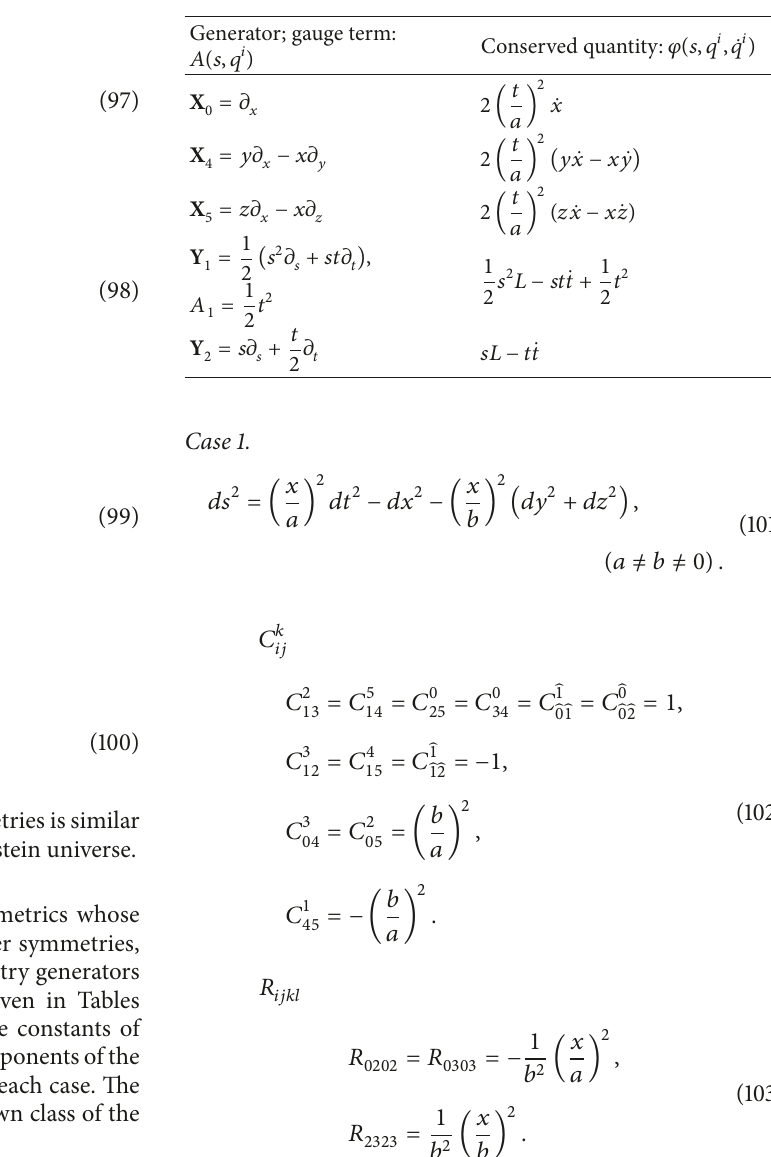
Table 17: Conserved quantities corresponding to each Noether